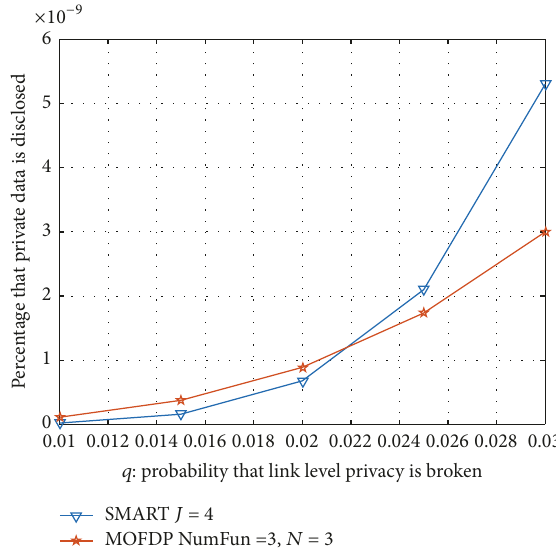
Figure 2: Comparison results when 𝐽 = 4 , NumFun = 3, 𝑁 = 3 .